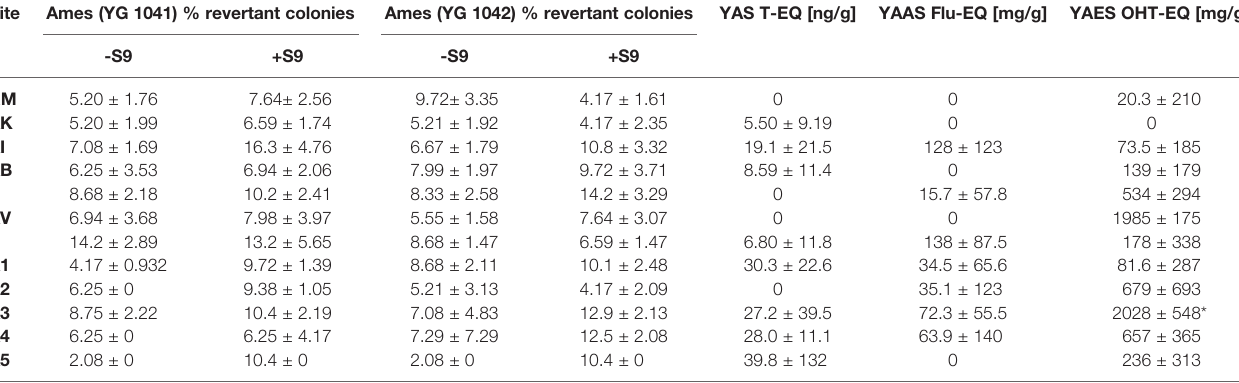
TABLE 2 | Speci fi c toxicity (mean ± SEM) of sediment samples collected in NW-Brittany, France (2012-2020) (LOQs: YAS: 52.6 ng T-EQ/g, YAAS: 310 mg Flu-EQ/g, YAES: 1710 mg OHT-EQ/g, *=p<0.05). Site Ames (YG 1041) % revertant colonies Ames (YG 1042) % revertant